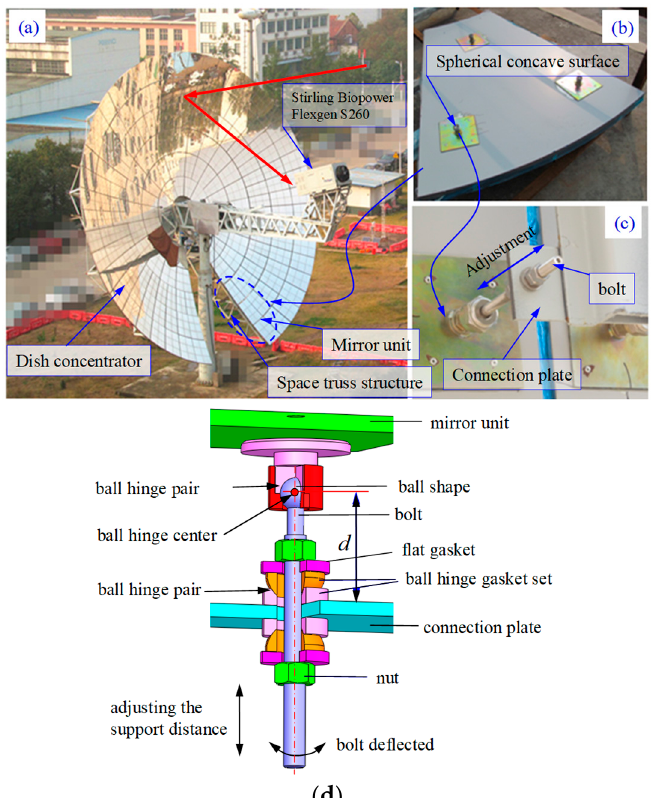
Figure 1. ( a ) Photograph of the 38 kW dish ‐ Stirling solar thermal power system (38 kW XEM ‐ Dish System), ( b ) Image of the posterior side of the mirror unit, ( c ) image of the support ‐ adjust structure on the back of the mirror unit, and ( d ) schematic of the assembly model of the support ‐ adjust structure.